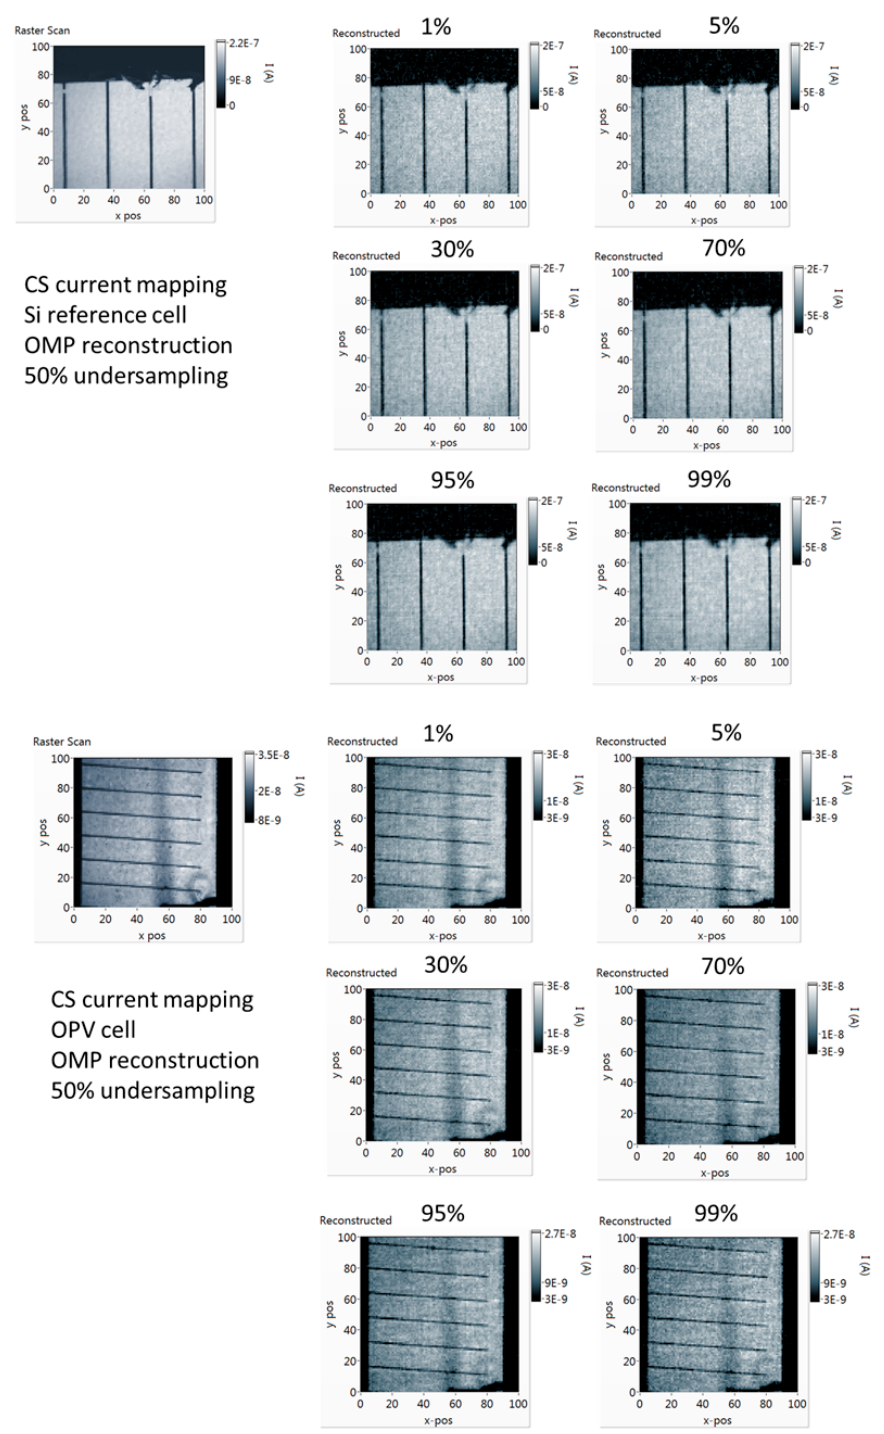
Figure 9. CS current mapping with sensing matrices with di ff erent sparsity levels (number of pixels in the “on” state). On the top left, the point-by-point scan is also included for comparison. It can be observed that the di ff erences in reconstruction performance for di ff erent sensing matrices are